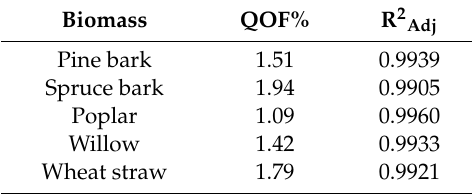
Table 8. Quality of the fit expressed as R 2 Adj and QOF%.